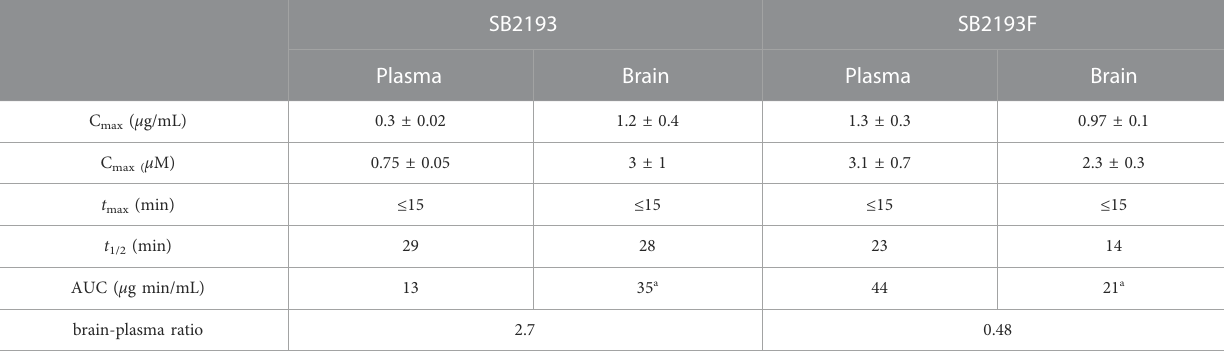
TABLE 2 Pharmacokinetics of SB2193 and SB2193F in mouse plasma and brain following single intraperitoneal injection (10